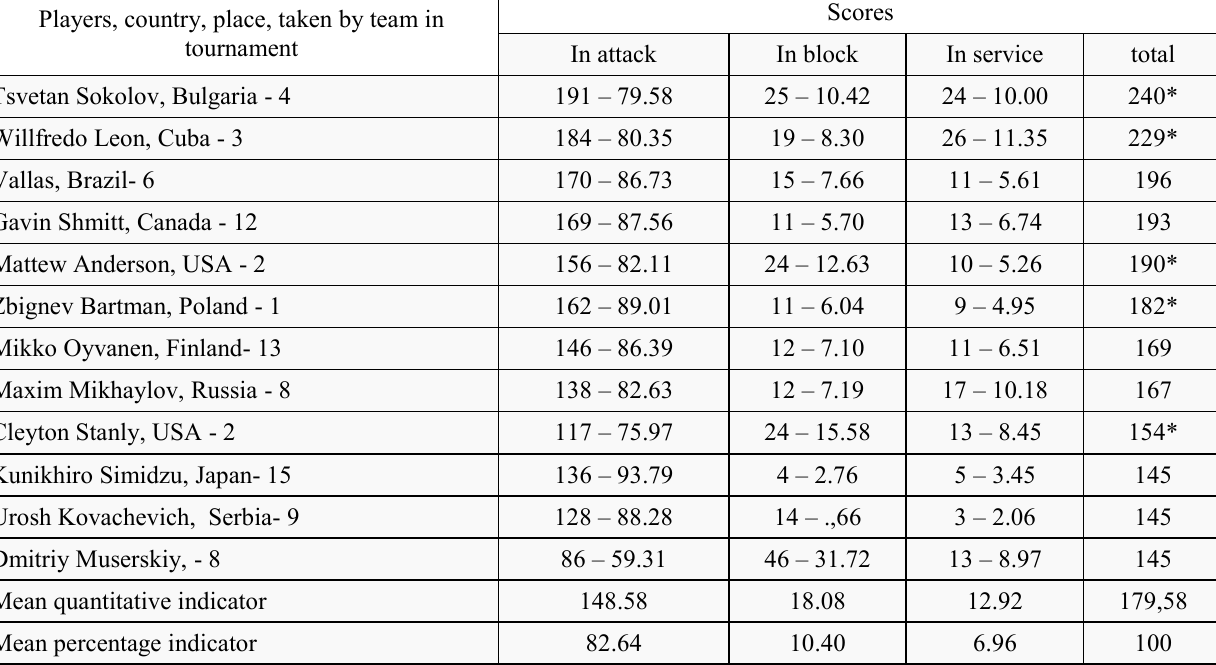
Technical-tactic actions’ indicators of highly qualified volleyball players (quantity of gained points) as